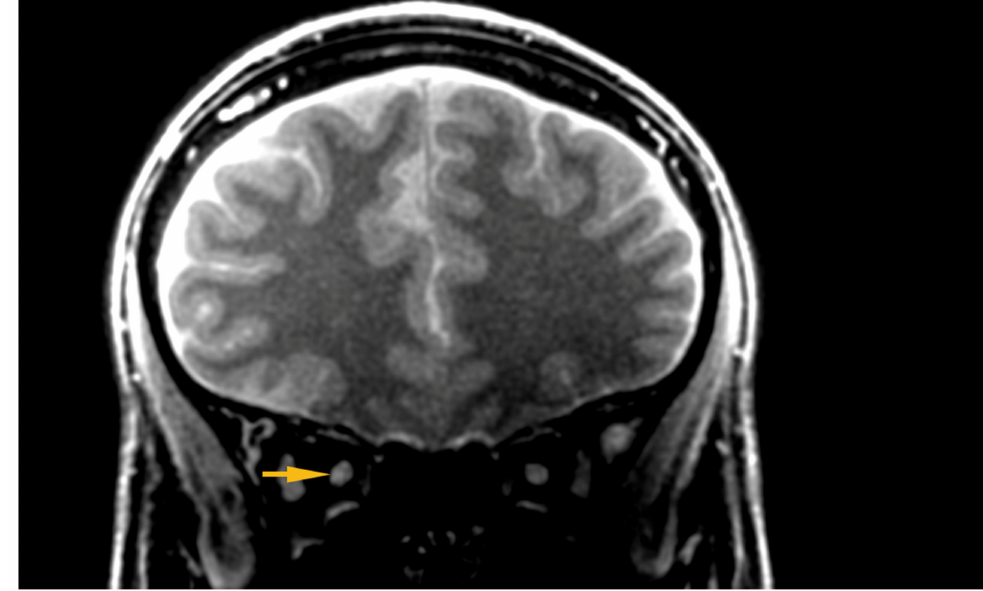
Figure 2. Hyper intensive area visible within the ONSC. ONSC, Optic Nerve Sheath Complex.